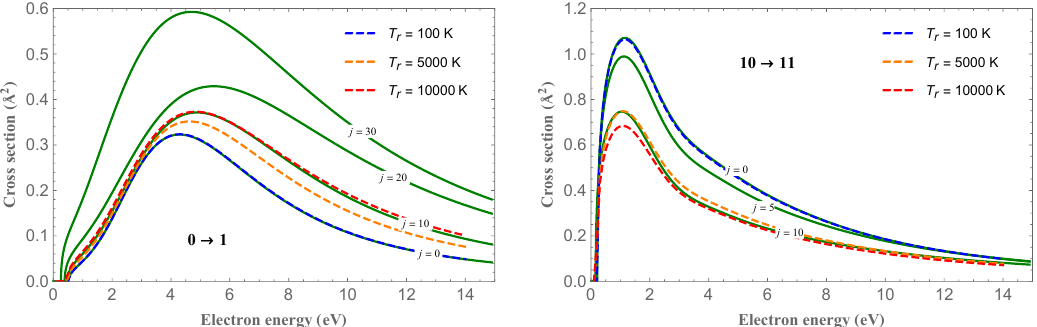
Figure 1. Full lines: resonant vibrational excitation (RVE) cross-sections for the transitions 0 → 1 (left panel) and 10 → 11 (right panel) and for different rotational states indicated in the panels. Dashed lines: thermally -averaged cross-sections for different rotational temperatures, T r , for the same vibrational